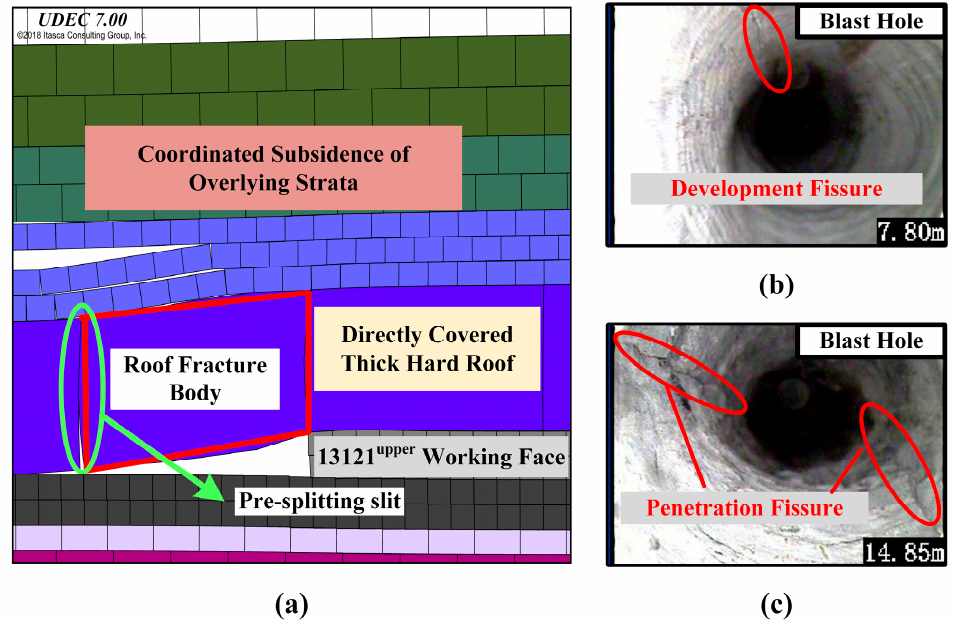
Figure 4. Pre-split roof structure: ( a ) the overburdened structure after using UDEC software to pre-split and cut a thick, hard roof; ( b ) the fracture development effect at a depth of 7.8 m; and ( c ) the crack development effect at a depth of 14.85 m.